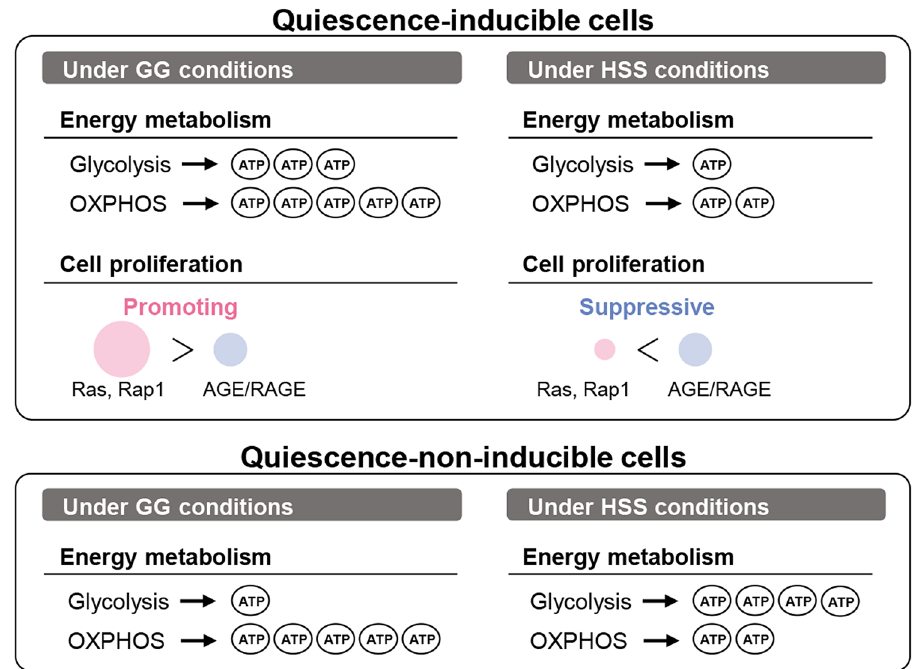
Figure 7. Schematic illustration of energy metabolism and regulation of cell proliferation. Both the quiescence- inducible and quiescence-non-inducible cells produce ATP by glycolysis and oxidative phosphorylation (OXPHOS) under GG conditions. Under HSS conditions, the quiescence-inducible H2228 and AsPC-1 cells produce a small amount of ATP mainly by OXPHOS and cell proliferation is suppressed through the advanced glycation end products (AGE)/receptor for AGE (RAGE) pathway, whereas the quiescence-non-inducible A549 cells activate glycolysis and produce a sufficient amount of ATP for cell